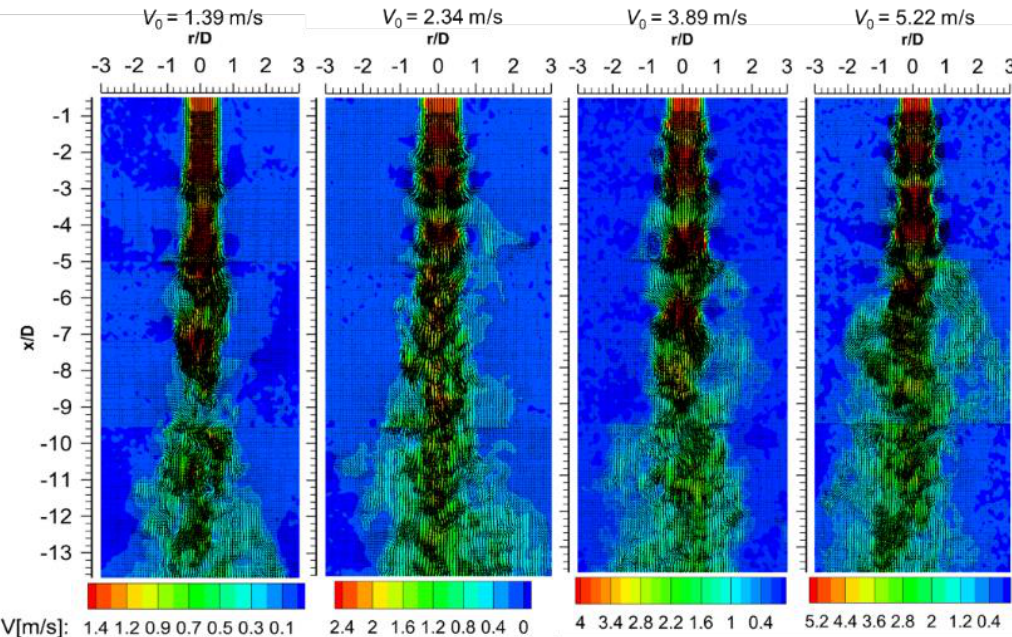
Figure 10. Instantaneous velocity fields with velocity vectors, streamlines and contours of their magnitudes. These images are selected arbitrarily out of 650 images and presented here as typical flow for each experimental condition.